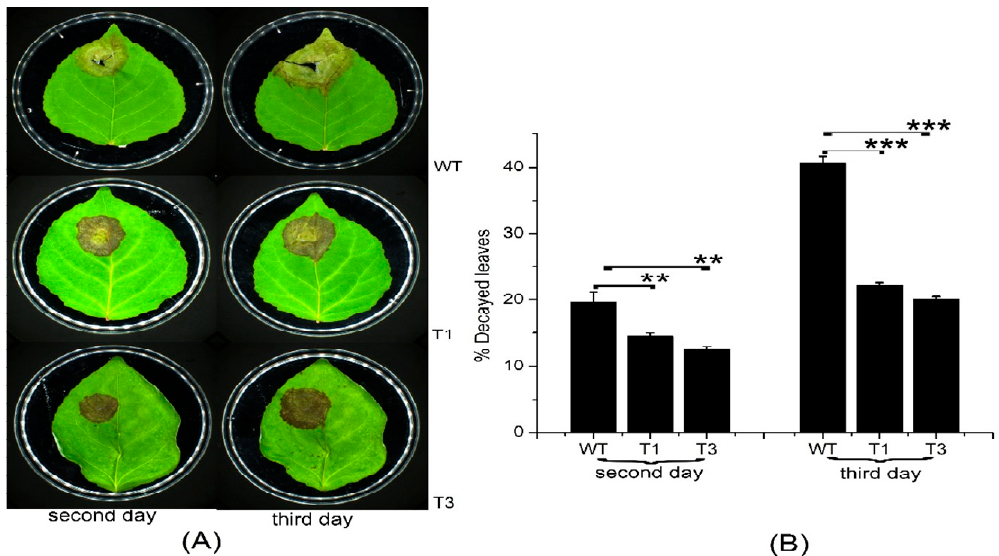
Figure 7. Necrotic symptoms of WT and transgenic plants infected with S . populiperda . ( A ) Leaves of WT and transgenic plants after inoculation. ( B ) Plaques on WT and transgenic plants. Three independent experiments were performed; three independent experiments were performed; asterisks represent significant differences relative to WT plants (Student’s t -test; **, and ***, p < 0.01, and p < 0.001, respectively).